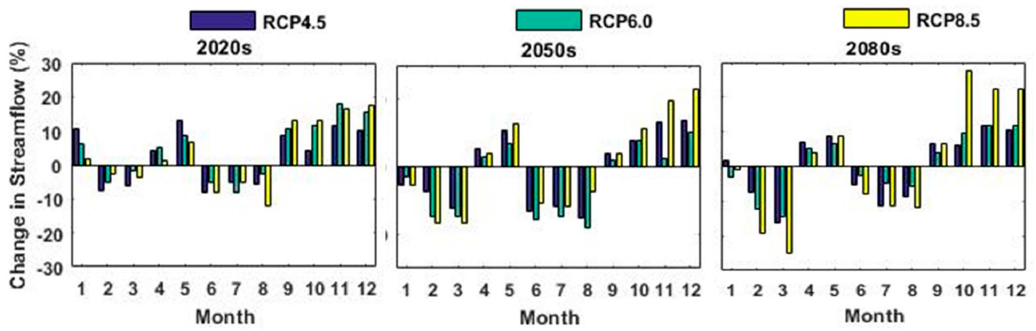
Figure 13. Average projected changes of monthly streamflow for the 2020s, 2050s and 2080s under RCP4.5, RCP6.0 and RCP8.5, with respect to the baseline simulation (1976–2005).